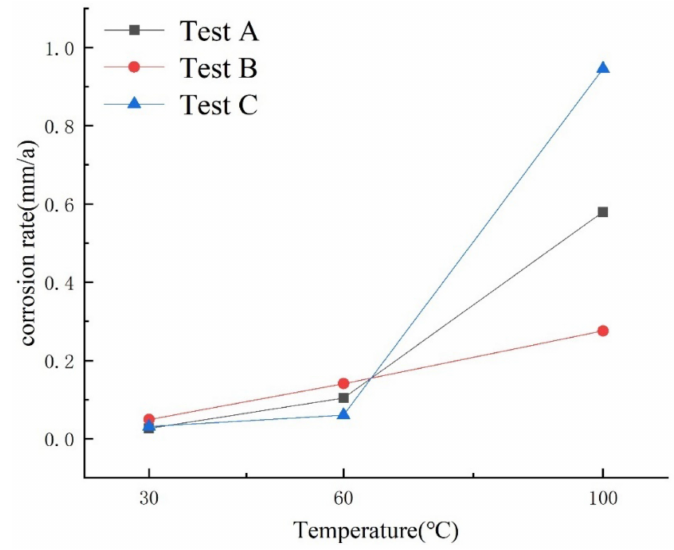
Figure 6. Corrosion rate–temperature curve.